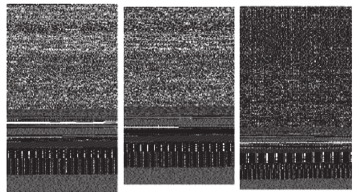
Figure 5. Image of goodware.